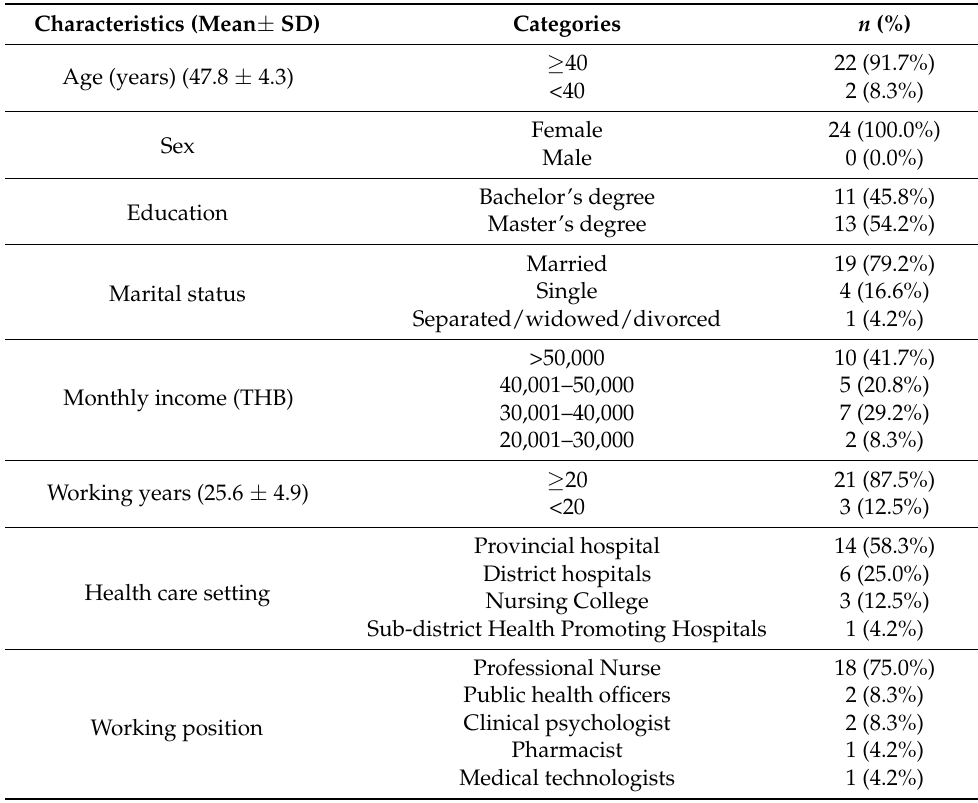
Table 7. Personal characteristics of respondents participating in the APTP-RCB interventions ( n =